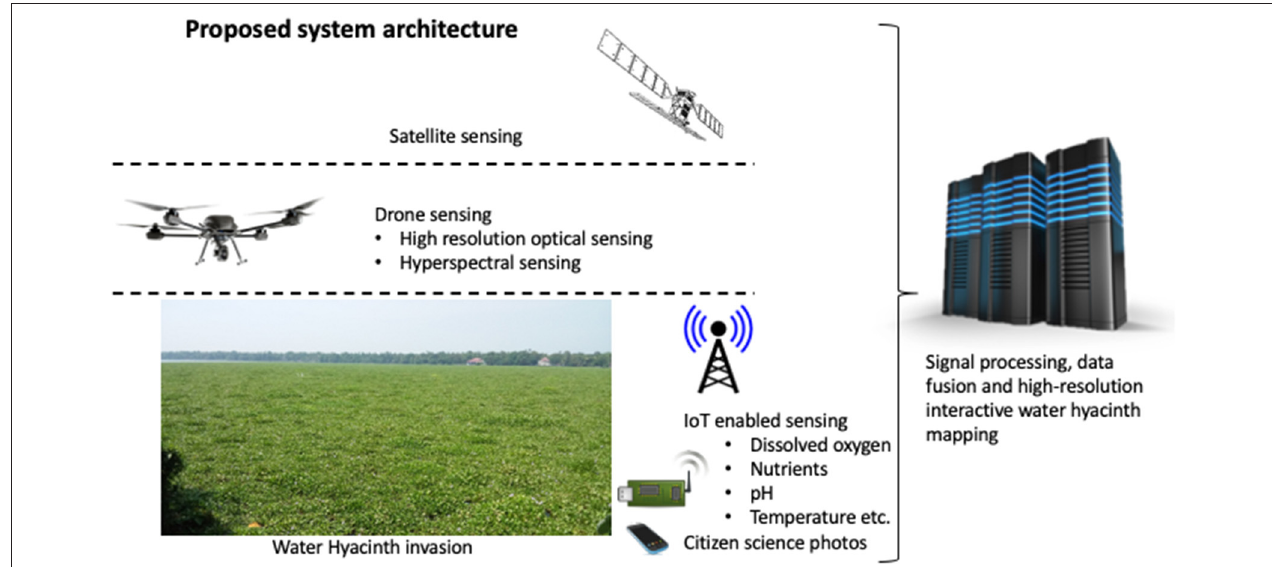
FIGURE 1 | Proposed system architecture for a multi-modal system for monitoring water hyacinth